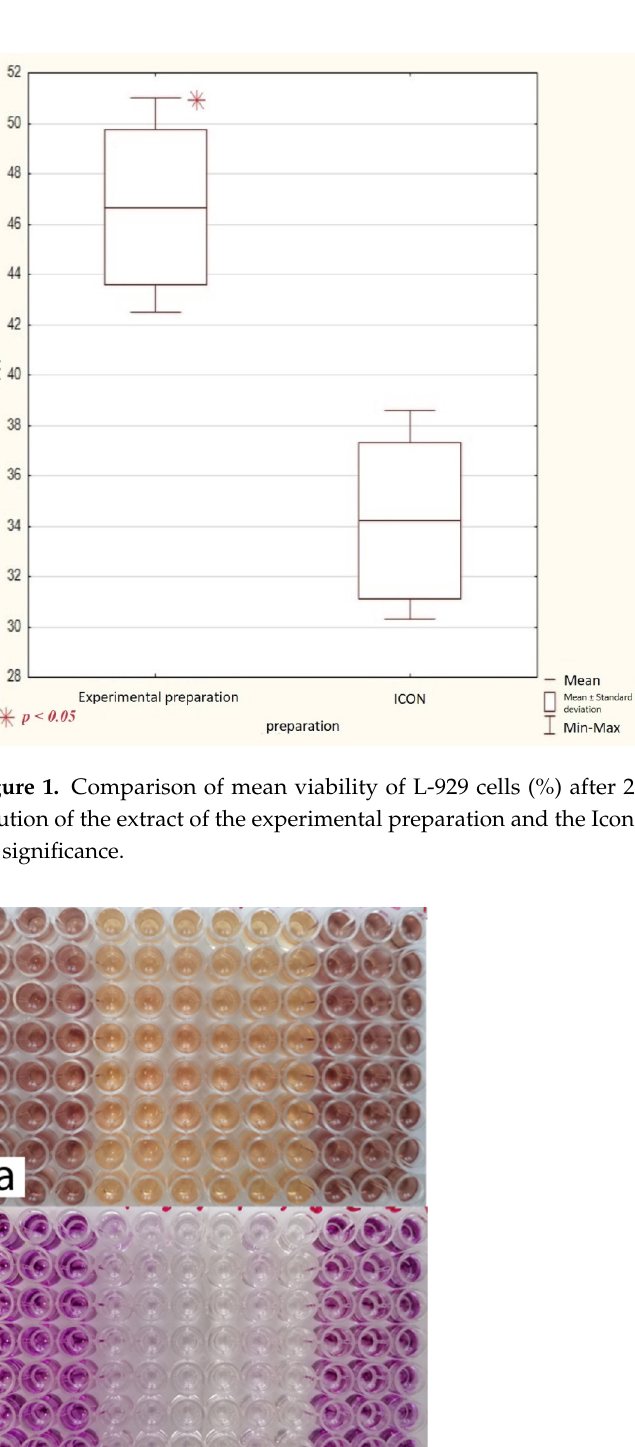
of DMSO is directly proportional to the cell viability.